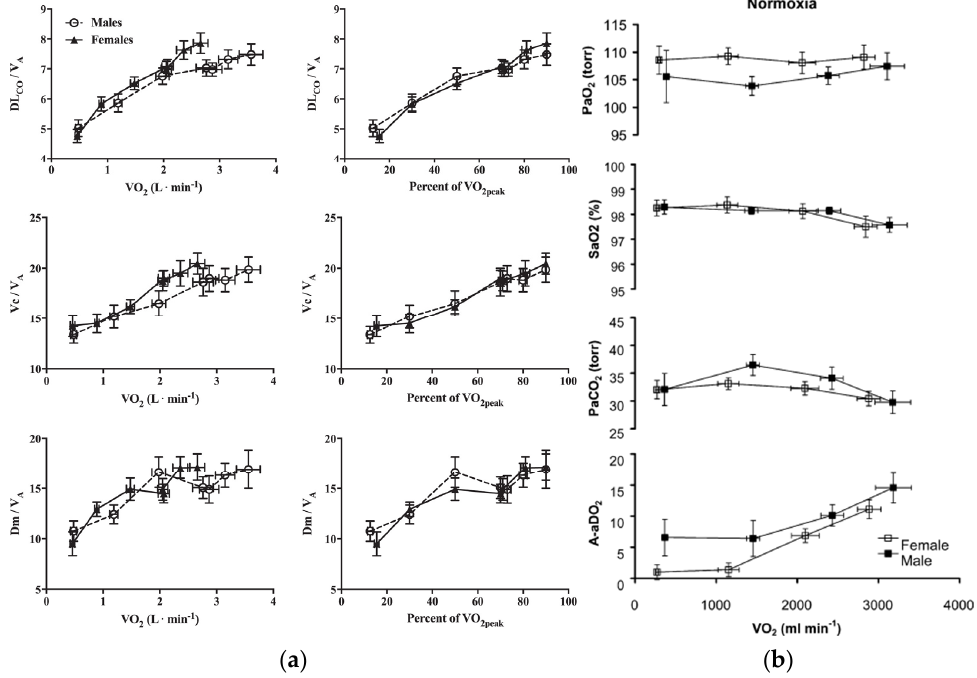
Figure 3. ( a ) Reprinted with permission from Ref. [49]. 2017 the American Physiological Society. Diffusion capacity, pulmonary blood volume, and membrane diffusing capacity responses to exercise, corrected for alveolar volume, in male and female subjects. No significant differences were found. ( b ) Reprinted with permission from Ref. [50]. 2004 The Physiological Society Arterial PO 2 , saturation, PCO 2 , and alveolar-arterial PO 2 difference at rest and during exercise in normoxia. Male and female subjects are matched for age, height, and VO 2max